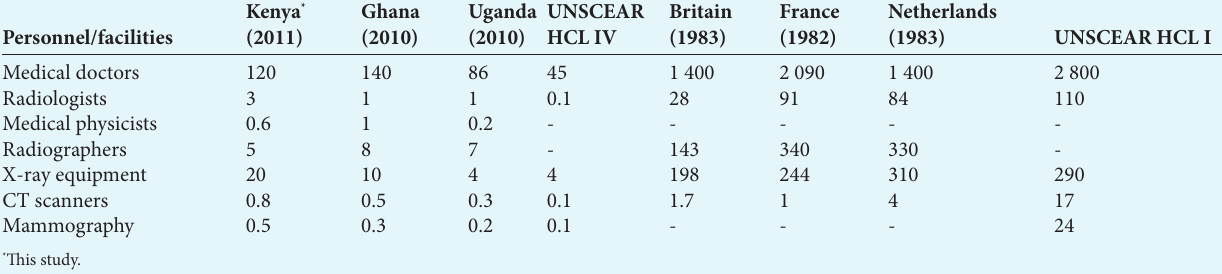
Table 2. Level of provision of medical radiology staff and facilities per million people [3,17]